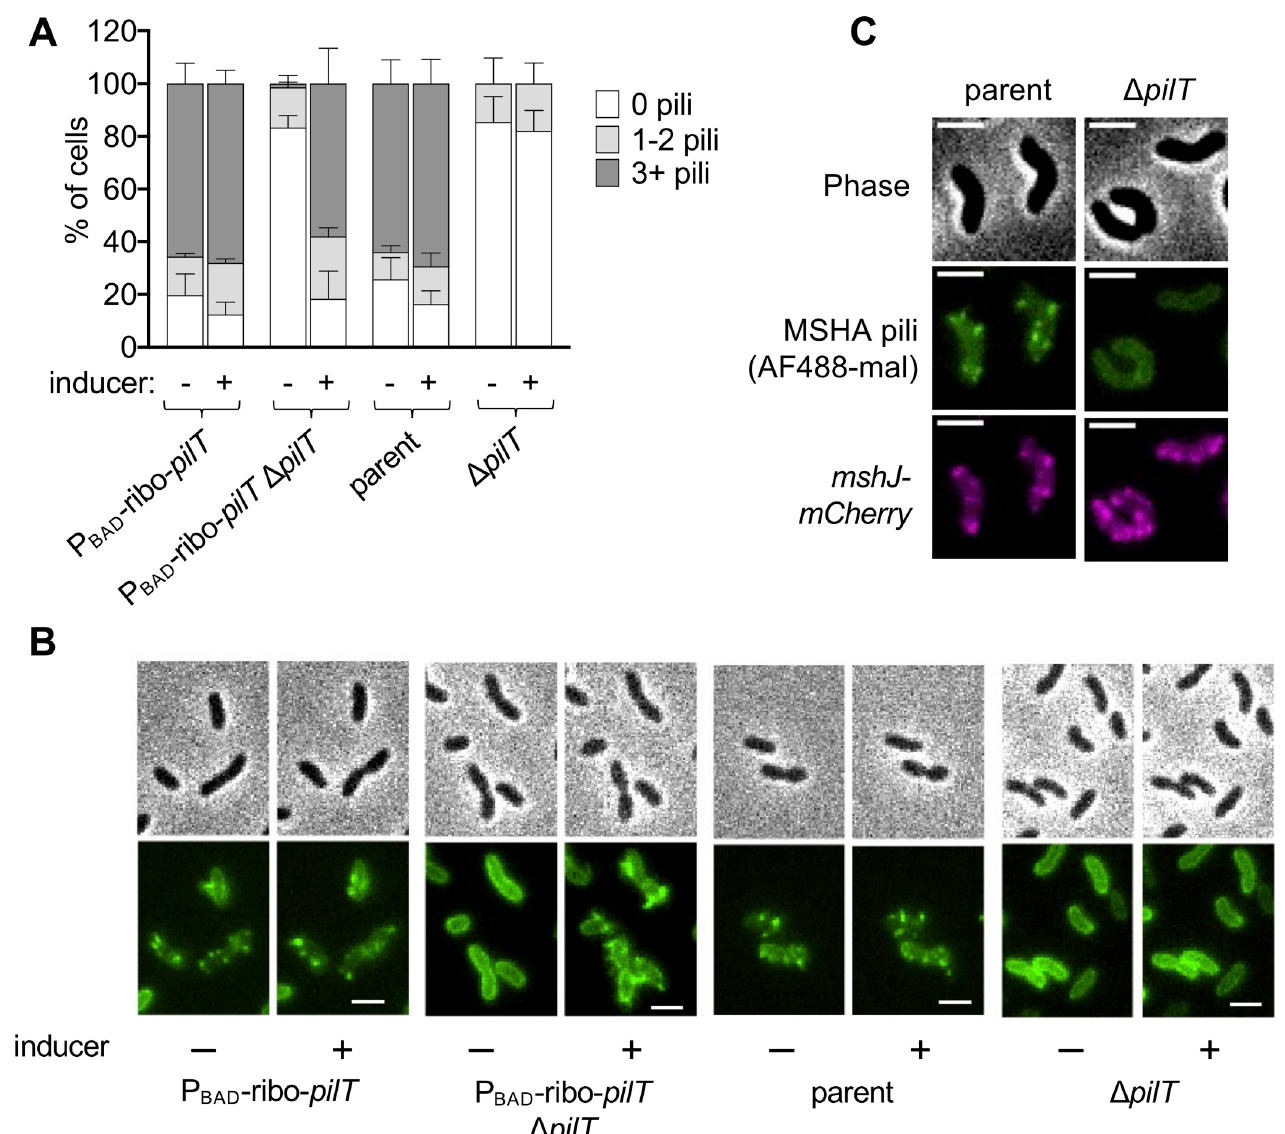
Fig 3. PilT promotes MSHA pilus extension. ( A ) Quantification of piliation in strains imaged before and after induction with 0.2% arabinose + 1.5 mM theophylline. Cells were categorized as either having no pili (white bars), 1–2 pili (light gray bars), or at least 3 pili (dark gray bars). n = 300 cells analyzed from three independent biological replicates for all samples and data are displayed as the mean ± SD. ( B ) Representative images of cells from strains in A . Phase images (top) show cell boundaries and fluorescence images (bottom) show AF488-mal labeled pili. Each sample is shown before (“-”) and after (“+”) induction. Scale bar = 2 μ m. ( C ) Representative images of parent and Δ pilT strains containing a functional MshJ-mCherry fusion to label MSHA T4P machines. Phase images (top) show cell boundaries, green images (middle) show AF488-mal labeled pili, and red images (bottom) show MshJ-mCherry localization. Scale bar = 2 μ